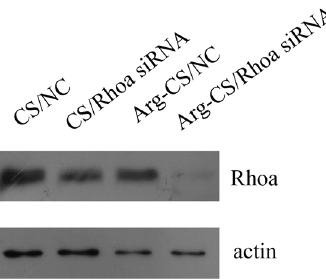
Figure 6. Rhoa could be knocked down in L1210 cells transfected with a 20:1 nanoparticle/siRNA ratio, as described in Section 4. Cells were collected, and antibodies to Rhoa and actin were used in a Western blot assay. Actin was used as a loading control.